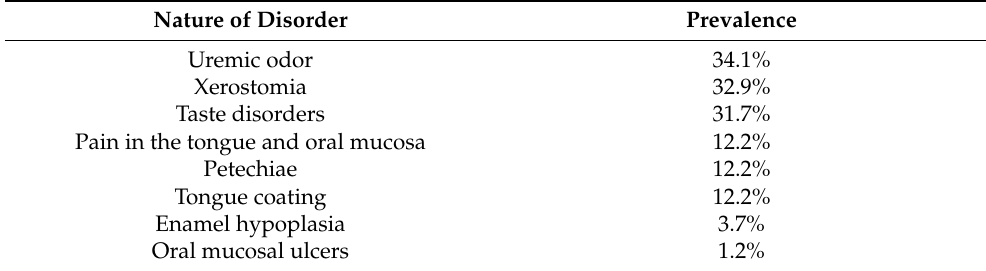
Table 1. Dental abnormalities resulting from chronic kidney disease, according to Kho et al. [2]. Nature of Disorder Prevalence Uremic odor